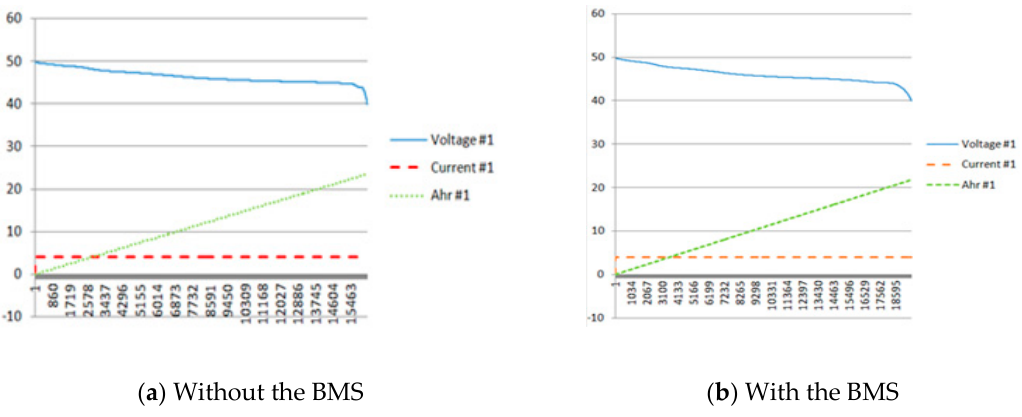
Figure 16. Embedded battery management board and an example of how the cell voltage was measured.